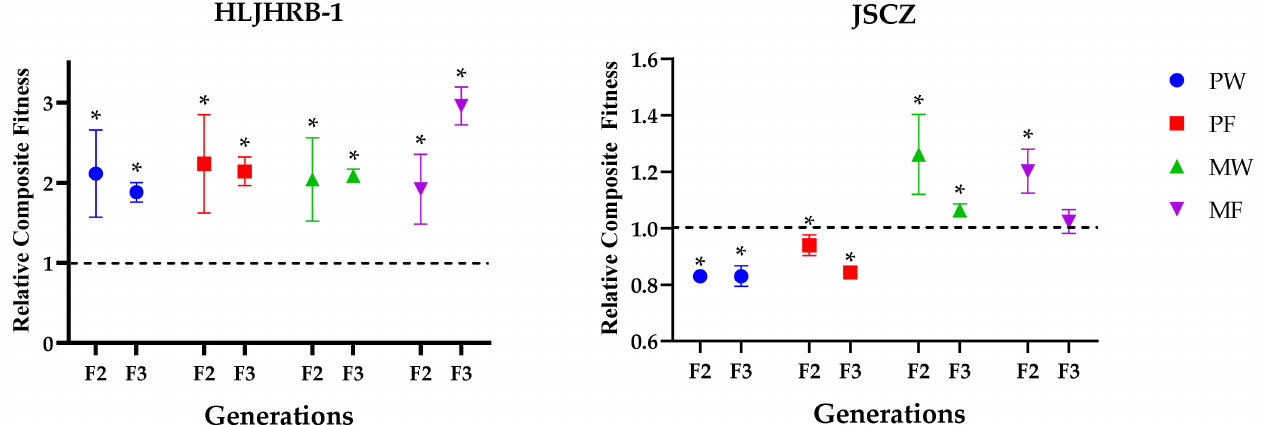
Figure 8. Comparison of composite fitness between wild soybeans and hybrids. Note: the dashed line represents the composite fitness of wild soybean as 1; * indicates significant difference ( p < 0.05) of the same trait between hybrids and the wild